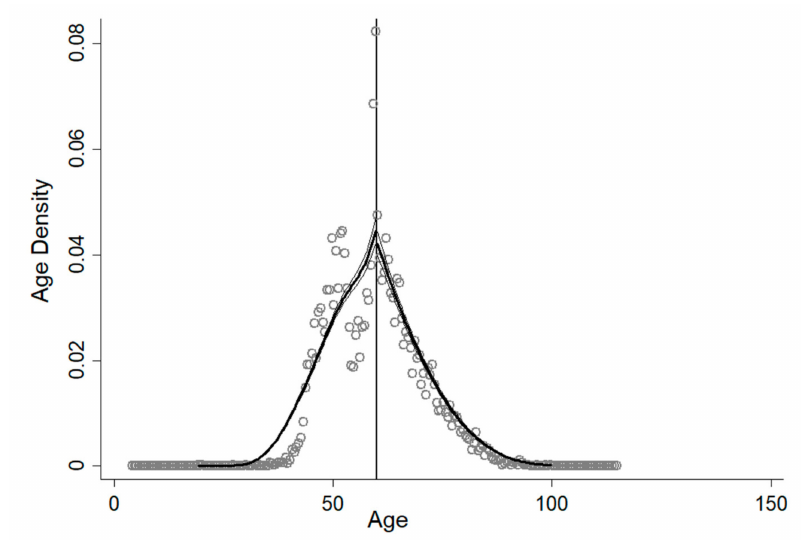
Figure 2. Testing the continuity of age density. Source: China Health and Retirement Longitudinal Survey (2015)